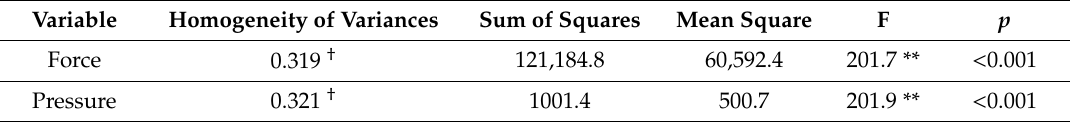
Table 2. One-way ANOVA for force and pressure values between groups ( n = 10).